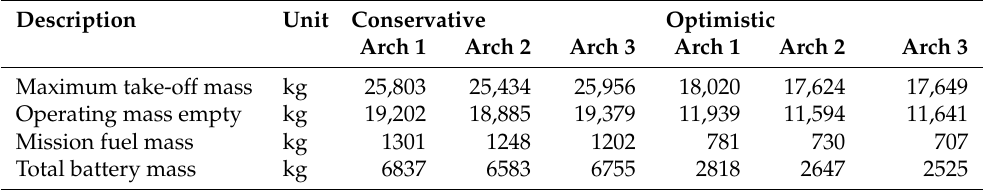
Table 7. Mass estimation from the initial sizing for Architectures 1 (TP), 2 (TP, WTP) and 3 (TP, BLI).